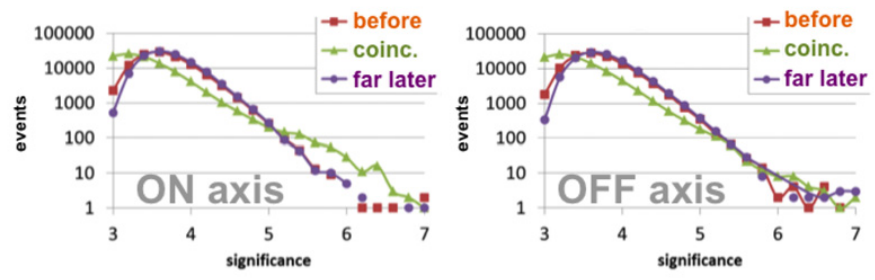
Figure 2. Histograms of the significance values in three different ranges in the